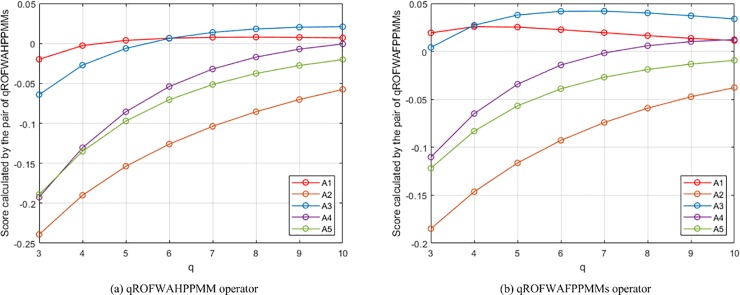
The results of Experiment 2.